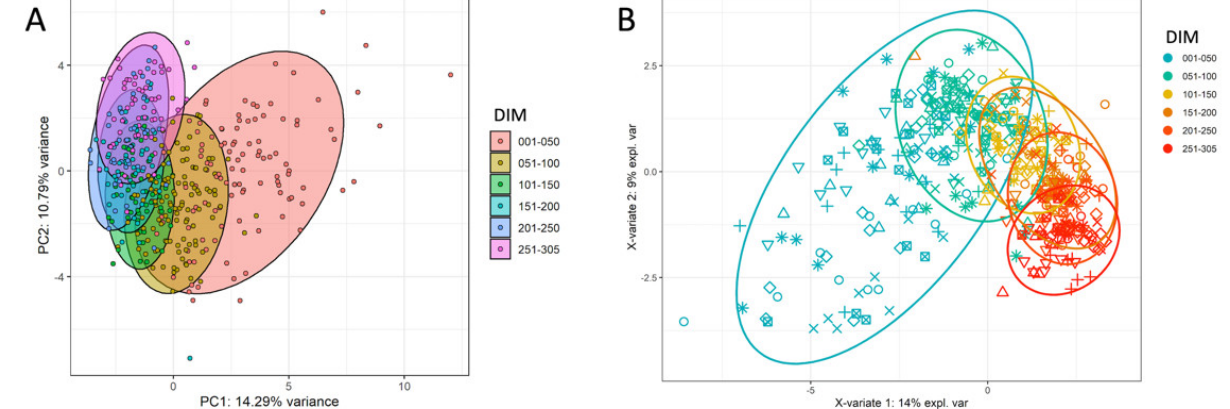
Figure 3. Results of different clustering methods, based on all measured parameters in the blood and milk. ( A ) PCA based on all parameters, shown here with the first principal component (PC1, 14.29% explained variance) and the second principal component (PC2, 10.79% explained variance). ( B ) sPLS-DA based on all parameters, shown here with the first component (X-variate 1, 14% ex- plained variance) and the second component (X-variate 2, 9% explained variance). (AUROC values: phase “001–050 DIM” vs. others: 0.985; phase “051–100 DIM” vs. others: 0.895; phase “101–150 DIM” vs. others: 0.893; phase “151–200 DIM” vs. others: 0.864; phase “201–250 DIM” vs. others: 0.9148; phase “251–305 DIM” vs. others: 0.9893.)